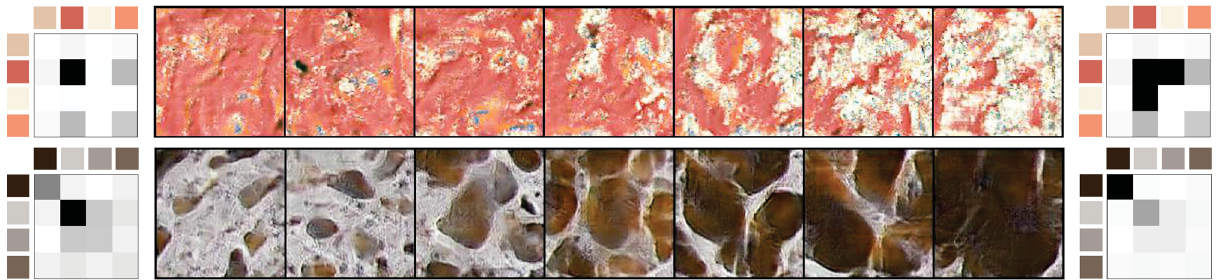
Fig. 13 Interactive texture editing. With our representation, a user can locally adjust the generated image by editing its corresponding co-occurrence matrix. On the left, we illustrate the initial result and its co-occurrence matrix. We demonstrate the sequence of results obtained by multiplying a selected bin with an increasing factor (and normalizing accordingly, as described in the text). The co-occurrence matrix on the right corresponds to the rightmost image. Note that darker colors correspond to pixel values which co-occur with high